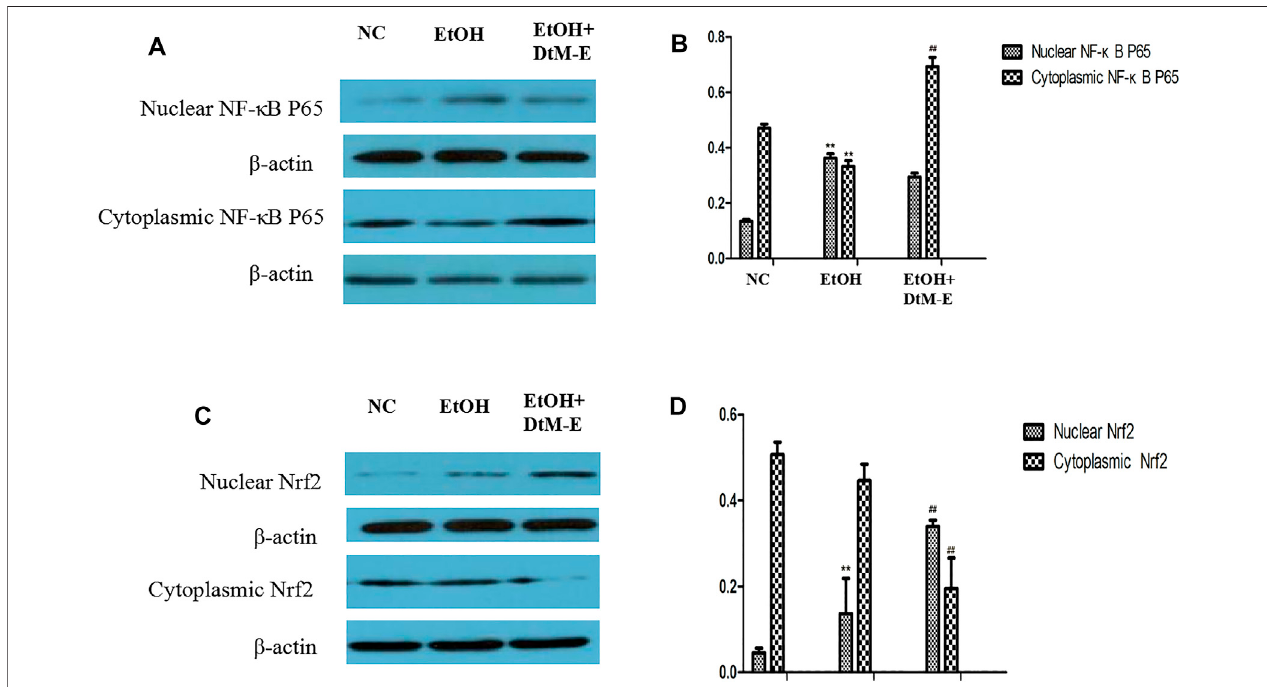
FIGURE 6 | The Western blot of nuclear and cytoplasmic NF- κ BP65 (A) , nuclear and cytoplasmic Nrf2 (C) . Quanti fi cation of nuclear and cytoplasmic NF- κ BP65 (B) , nuclear and cytoplasmic Nrf2 (D) expression. All data are presented as mean ± SD ( n = 6). ** p < 0.01, ( vs . control group); ## p < 0.01 ( vs . model group).